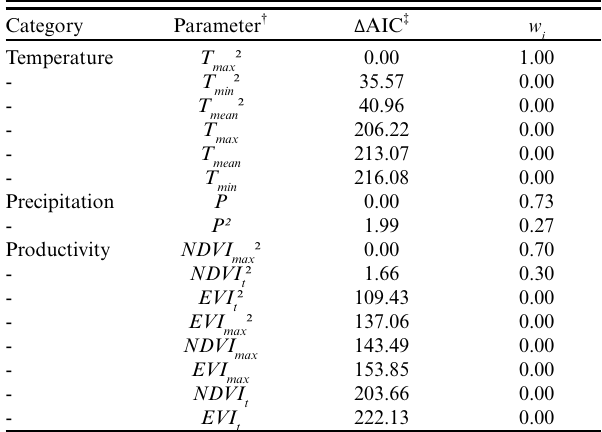
Table 1 . Parameter selection for each of three environmental hypothesis categories, ranked by AIC weight (w